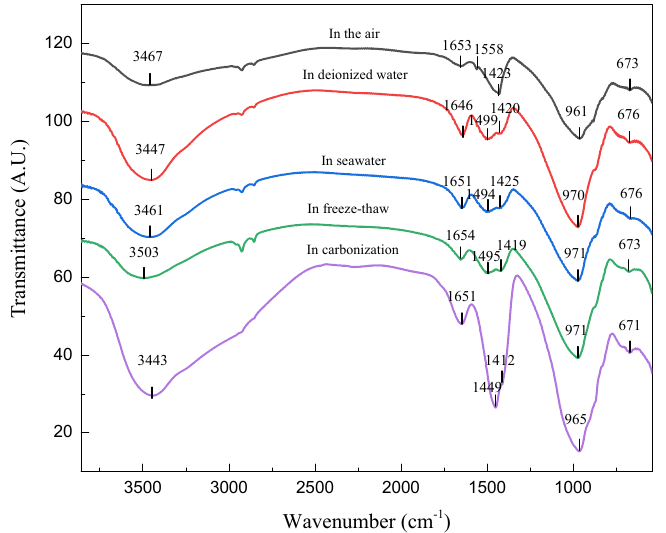
Figure 4. FTIR spectra of the geopolymers prepared with 60% BFS subjected to different exposures for 28 days.